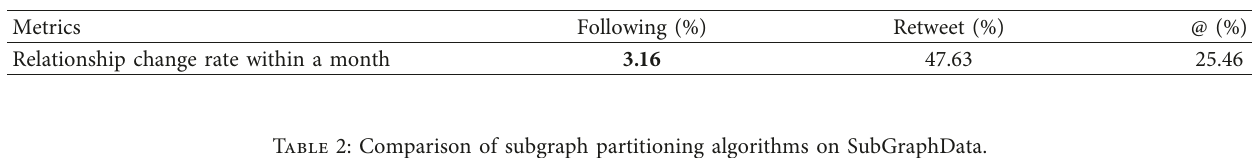
Table 1: Changes in different social relations on WeiboData.